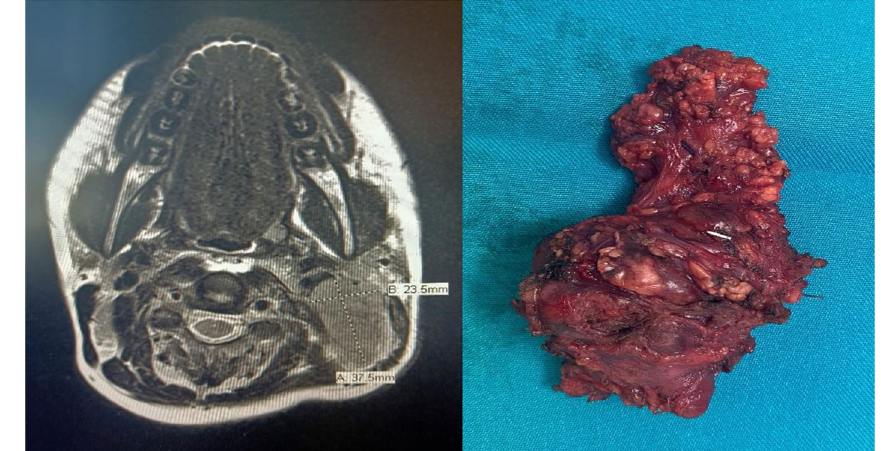
Fig. 2 Mucoepidermoid carcinoma: MRI axial cut, and the